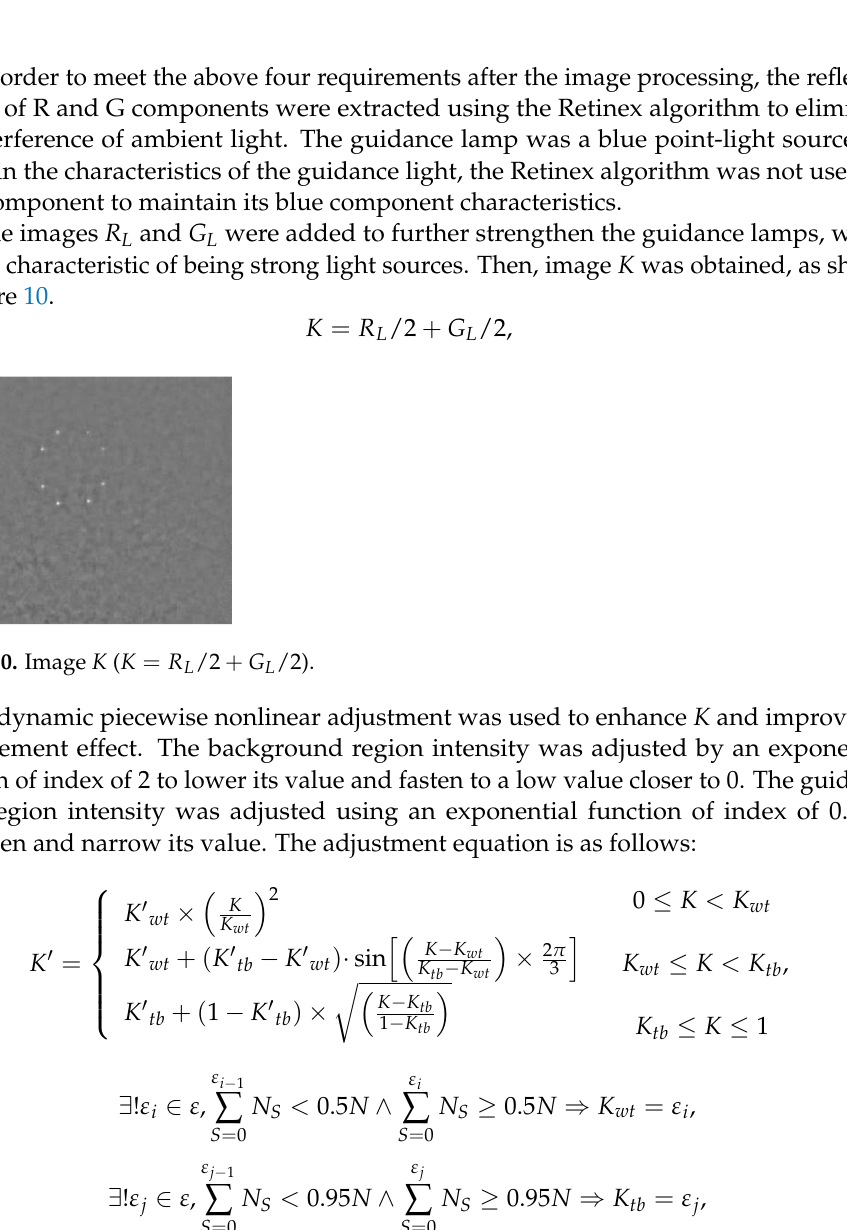
( b ) reflection image of green components.